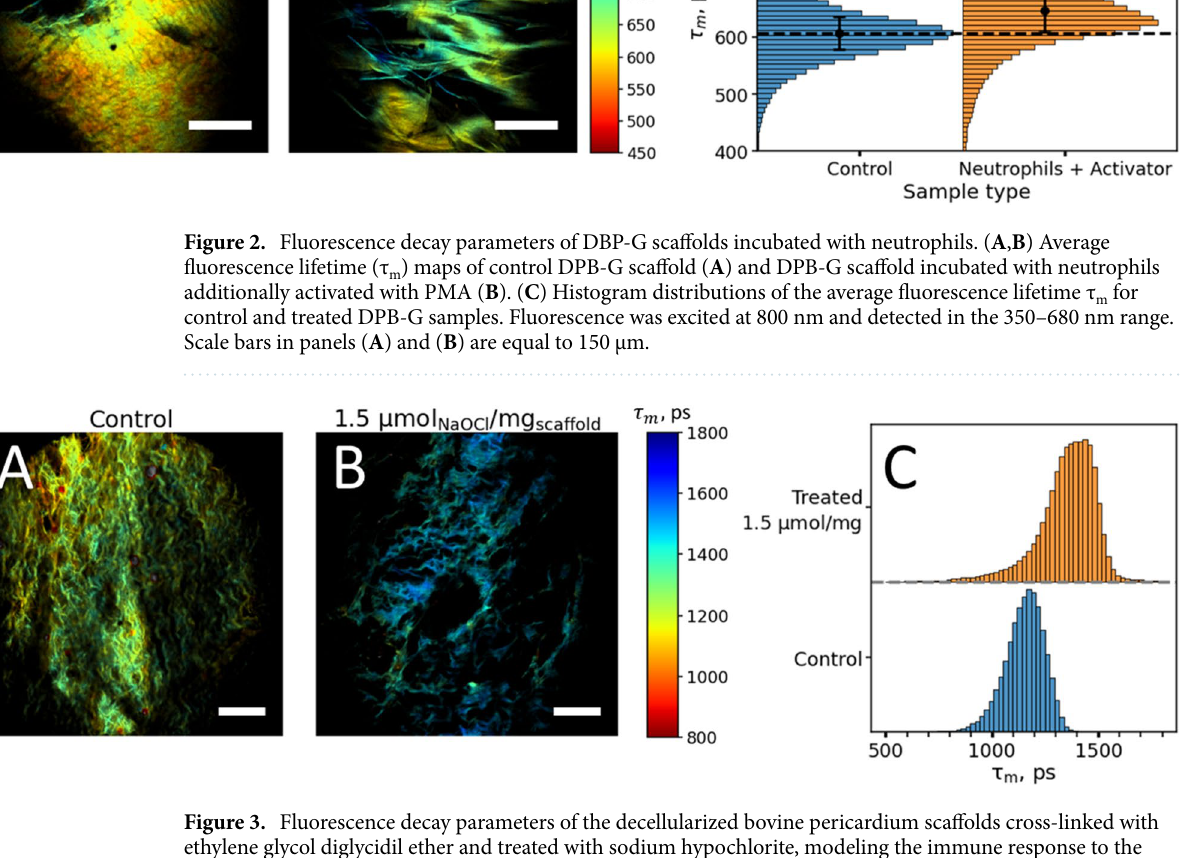
Figure 3. Fluorescence decay parameters of the decellularized bovine pericardium scaffolds cross-linked with ethylene glycol diglycidil ether and treated with sodium hypochlorite, modeling the immune response to the biomaterial. ( A , B ) Average fluorescence lifetime (τ m ) maps of control DPB-EGDE scaffold ( A ) and DPB- EGDE scaffold, treated with 1.5 µmol (NaOCl)/mg (scaffold) ( B ). ( C ) Histogram distributions of the average fluorescence lifetime τ m for DPB-EGDE samples treated with different concentrations of sodium hypochlorite. Fluorescence was excited at 730 nm and detected in the 350–680 nm range. Scale bars in panels ( A ) and ( B ) are equal to 150